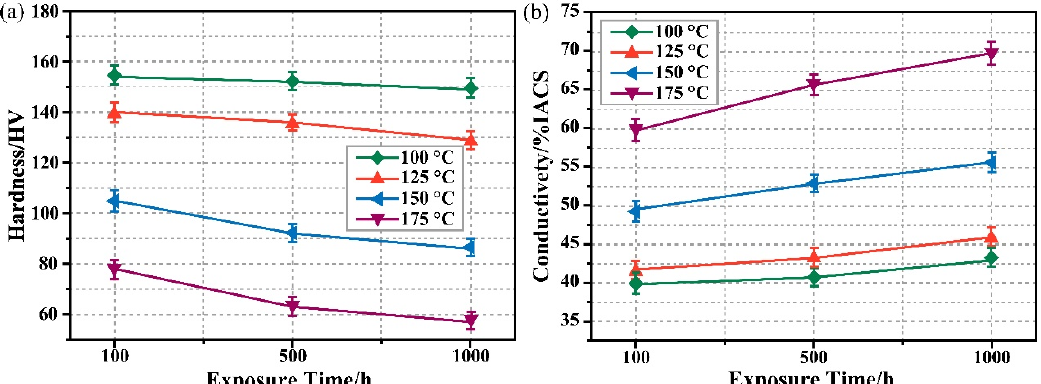
Figure 2. Effects of thermal exposure and tensile test time on hardness ( a ) and electrical conductivity ( b ) of 7085-T74 Al alloy. Table 2. The five representative samples of the 7085 Al alloy chosen for the tests. Sample No.